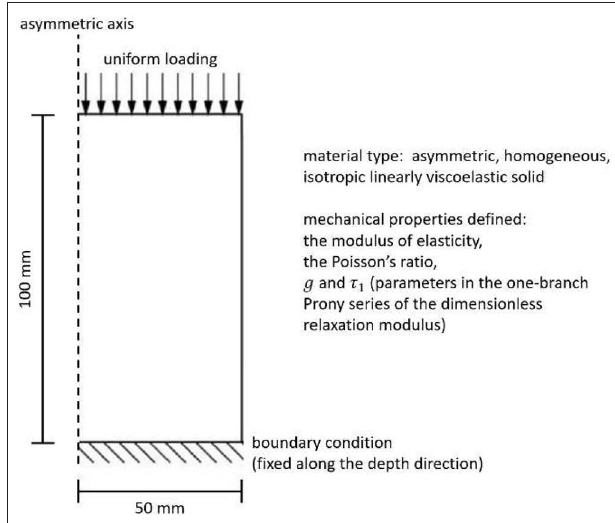
FIGURE 5 | Geometry and basic setting of the model for the finite element simulation.